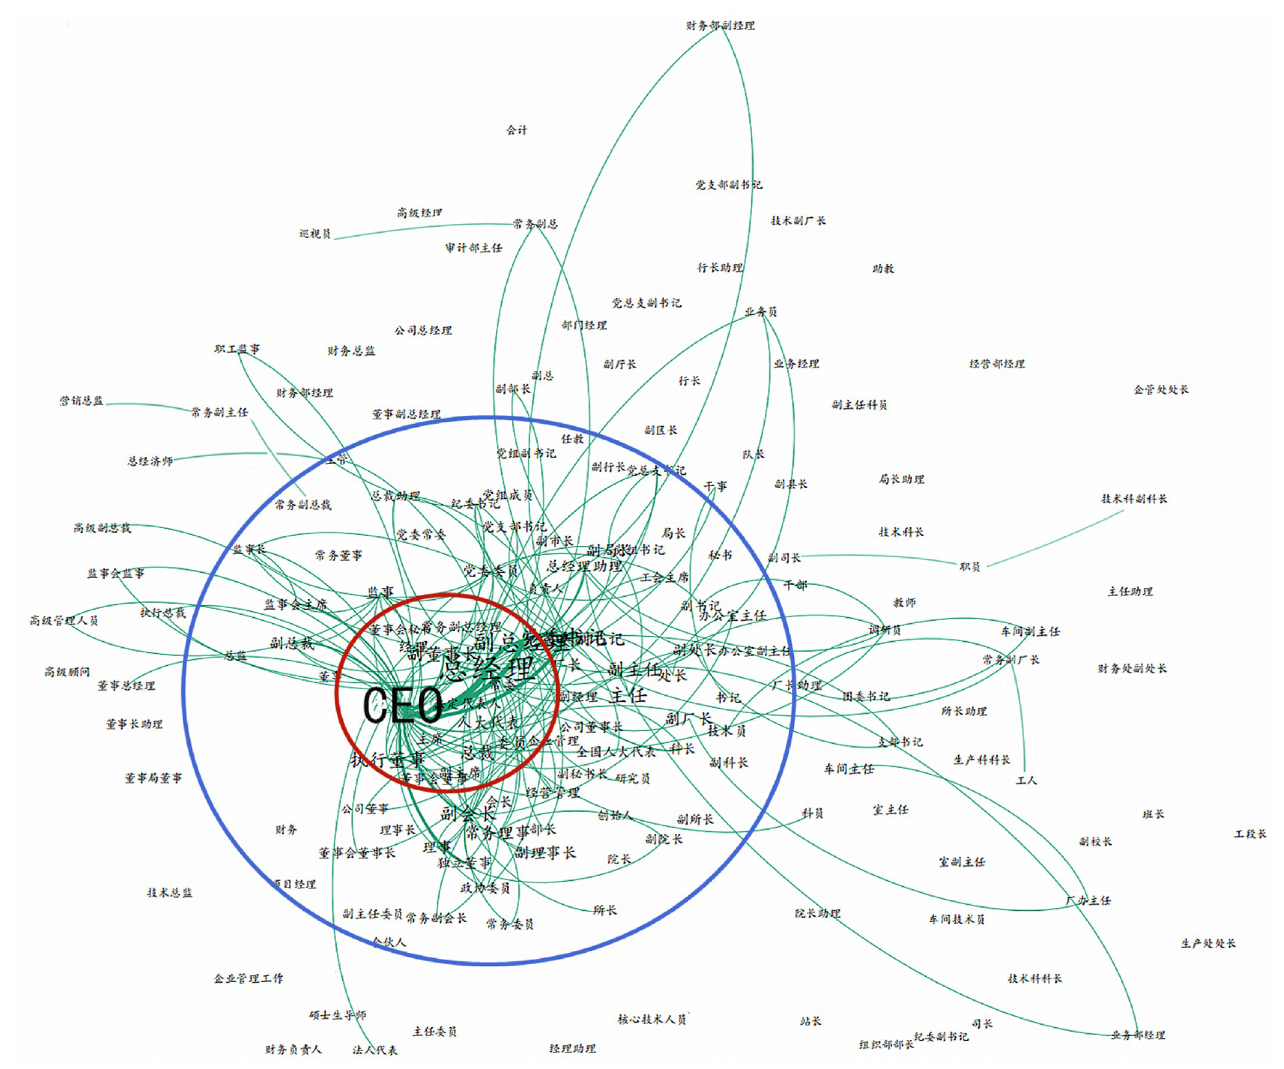
Fig 1. Evolution of CEO’s position promotion